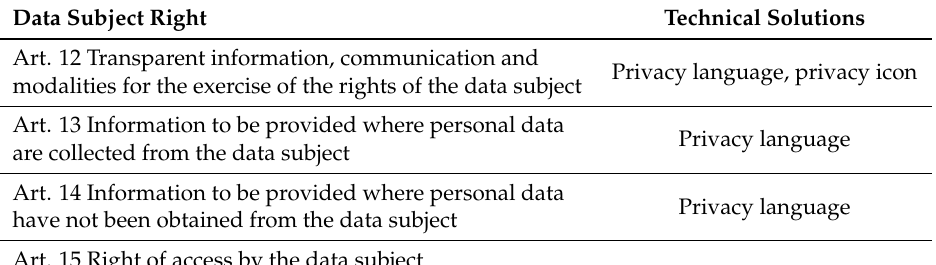
Table 8. Overview of Data Subject Rights and proposed technical solutions to solve